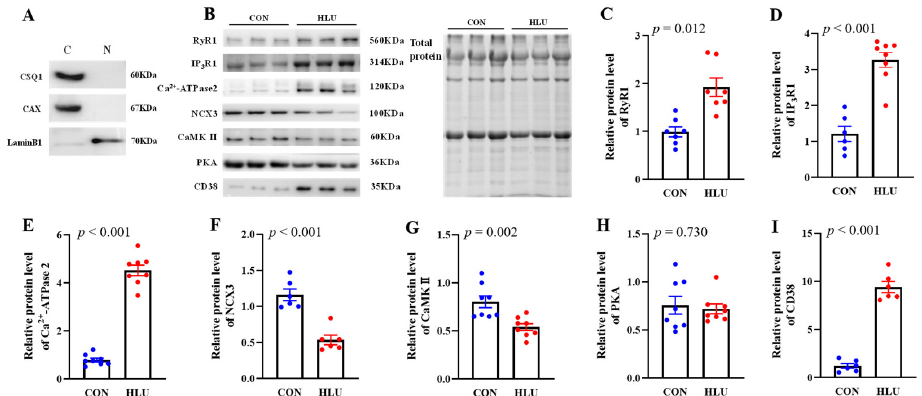
Figure 4. Relative expression level of Ca 2+ transporters located on nuclear membrane and its regu- latory proteins. ( A ) Representations of Calsequestrin 1 (CSQ1), Calnexin (CAX), Lamina protein B1 (LaminB1) in cellular protein fraction and nuclear protein fraction. C: cellular protein fraction; N: nuclear protein fraction. ( B ) Bands of Ca 2+ transporters and its regulatory proteins. ( C – I ) Relative expression levels of Ryanodine receptor 1 (RyR1), Inositol 1,4,5-tetrakisphosphate receptor 1 (IP 3 R1),